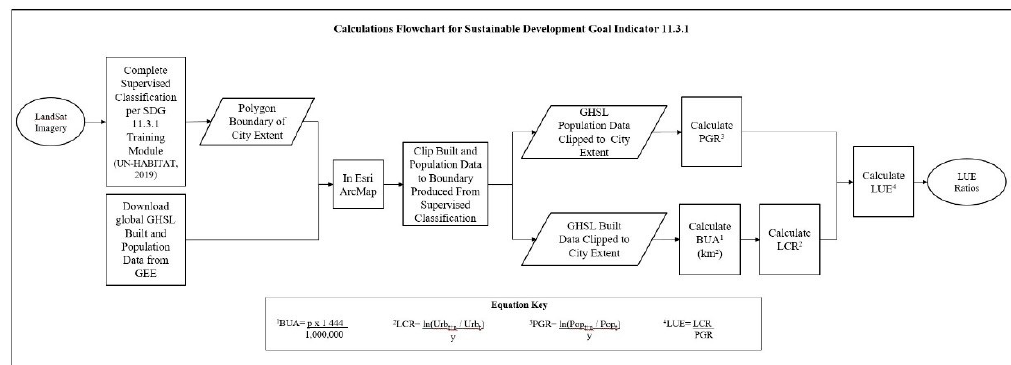
Figure 3. Steps to complete land consumption rate (LCR) calculation and land consumption rate to population growth rate or Land Use Efficiency (LUE) ratio from Sustainable Development Goal Indicator (SDGI) 11.3.1. We completed a supervised classification using LandSat imagery per instructions set out in the SDG 11.3.1 Training Module (UN-HABITAT, 2019). We downloaded the GHSL Built and Population datasets from Google Earth Engine (GEE). In Esri ArcMap, we clipped the Built and Population datasets to the polygon boundary produced from the supervised classification that define the city extent. We calculated the built-up area (BUA), which lead to completing the LCR calculation. We calculated the PGR, then calculated the LUE to get the land consumption to population growth ratio. Table 2. Built-up areas and population for Denpasar, Indonesia, Kharkiv, Ukraine, and Mekelle, Ethiopia. Built-up Area (km 2 ) City